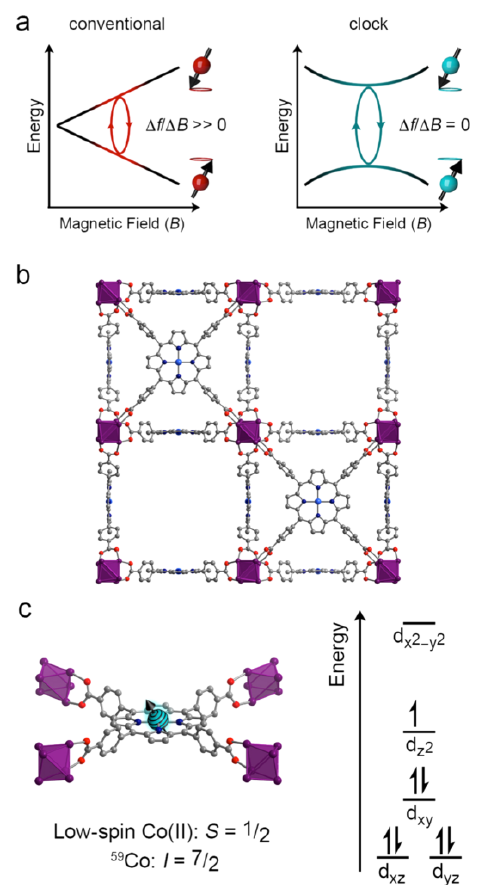
Figure 12. ( a ) Depiction of the clock concept for electronic spin qubits. Clock EPR transitions possess frequencies ( f ) that are insensitive to small changes in magnetic field ( Δ B). This property may enable a long T2 in magnetically noisy environments relative to a conventional EPR transition. ( b ) Crystal structure of the parent [(TCPP)-Co] 3 [Zr 6 O 4 (OH) 4 (H 2 O) 6 ] 2 framework (TCPP = tetrakis(4-carboxyphenyl)-porphyrin) [128]. This material is porous, exhibiting a high surface area ( ∼ 3200 m 2 /g), and hosts paramagnetic cobalt(II) metal ions. ( c ) Close-up view of the square-planar cobalt(II) ions in the structure and qualitative depiction of the d-orbital splitting. The cobalt(II) ions are low-spin, featuring one unpaired electron that is strongly coupled to the I = 7 / 2 59 Co nucleus. This strong hyperfine interaction engenders an avoided crossing such as that shown in (a). Purple = Zr. Cyan = Co. Grey = C. Red = O. Adapted with permission from [128]; Published by American Chemical Society, 2017.